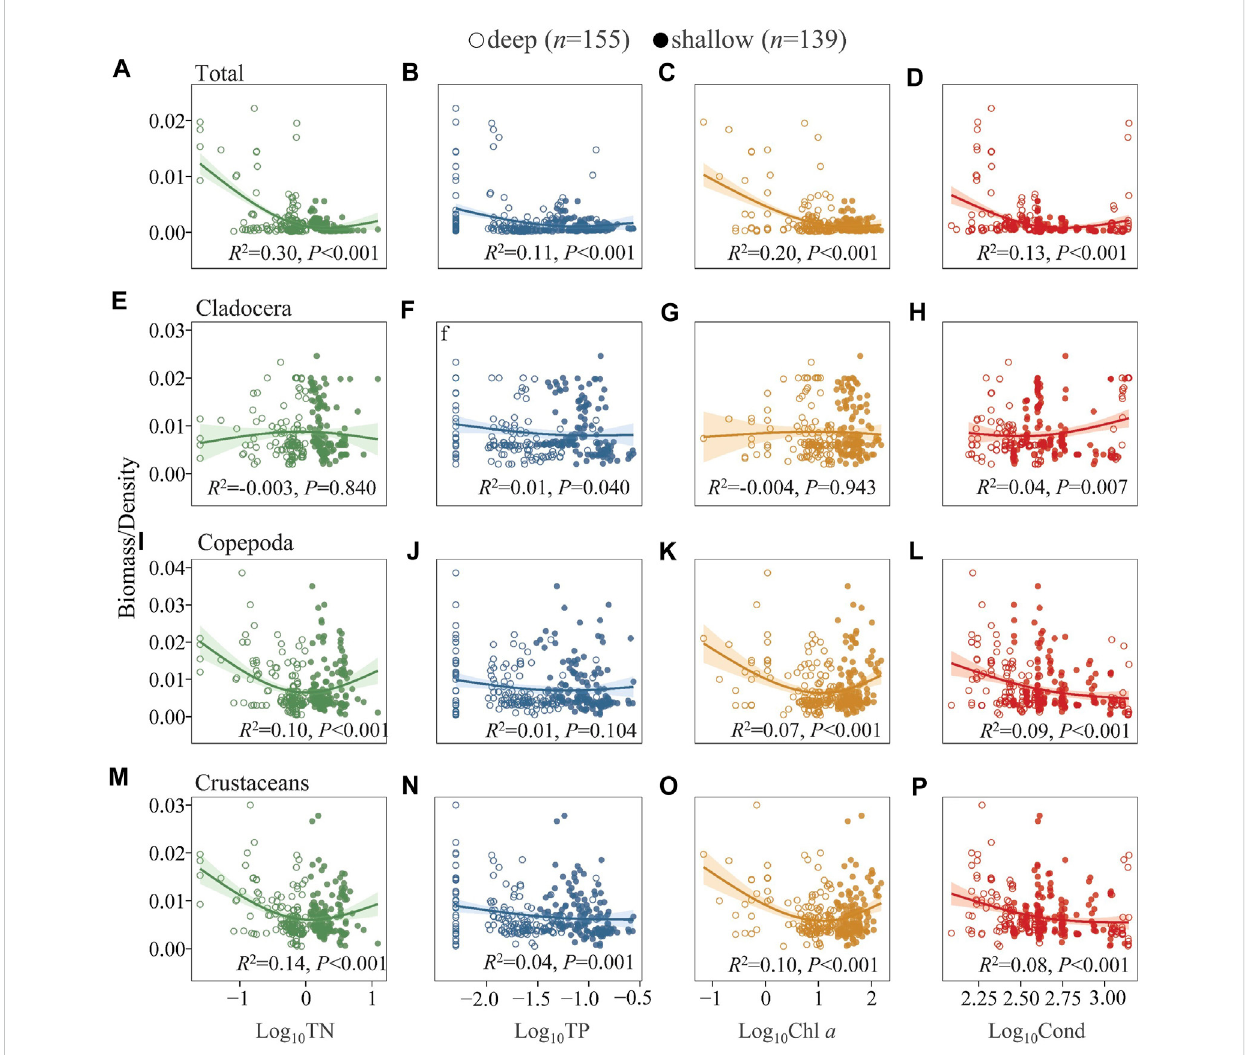
Generalized additive model of the relationships between TN, TP, Chl a, and Cond with the biomass/density of total zooplankton (A – D) , Cladocera (E – H) , Copepoda (I – L) , Crustaceans (M – P) in the studied lakes. See Figure 4 for the classi fi cation of deep and shallow lakes and Supplementary Table S6 for model